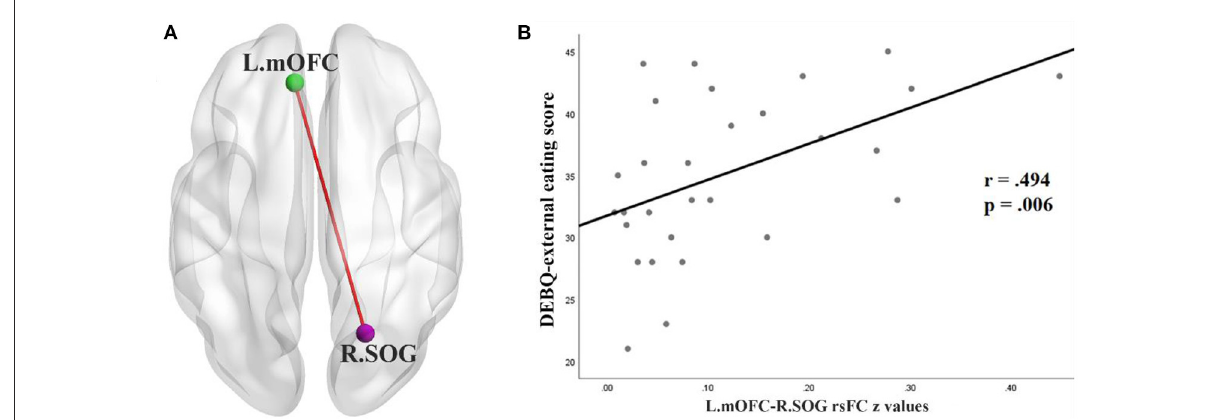
FIGURE3 (A) rsFC between the left OFC (L.mOFC) and right SOG (R.SOG) in patients with BN. (B) Correlation in the BN patients between DEBQ-external eating scores and rsFC values for the L.mOFC—R.SOG ( p < 0.05 corrected with FDR). rsFC, resting-state functional connectivity; mOFC, medial orbitofrontal cortex; SOG, superior occipital gyrus; DEBQ, Dutch Eating Behavior Questionnaire; FDR, false discovery rate.